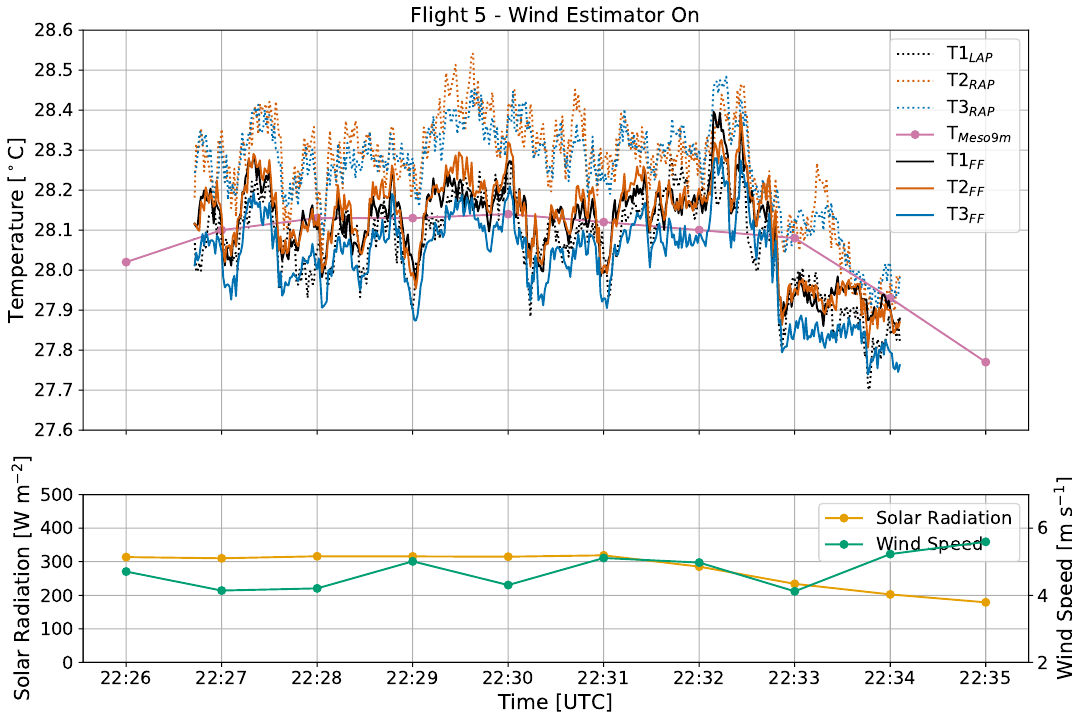
Figure 8. Time series of temperature [ ◦ C], solar radiation [W m − 2 ], and wind speed [m s − 1 ] from flight 5, with the same labeling conventions used as in Figure 6. The wind estimator was on and the CopterSonde was oriented directly into the oncoming